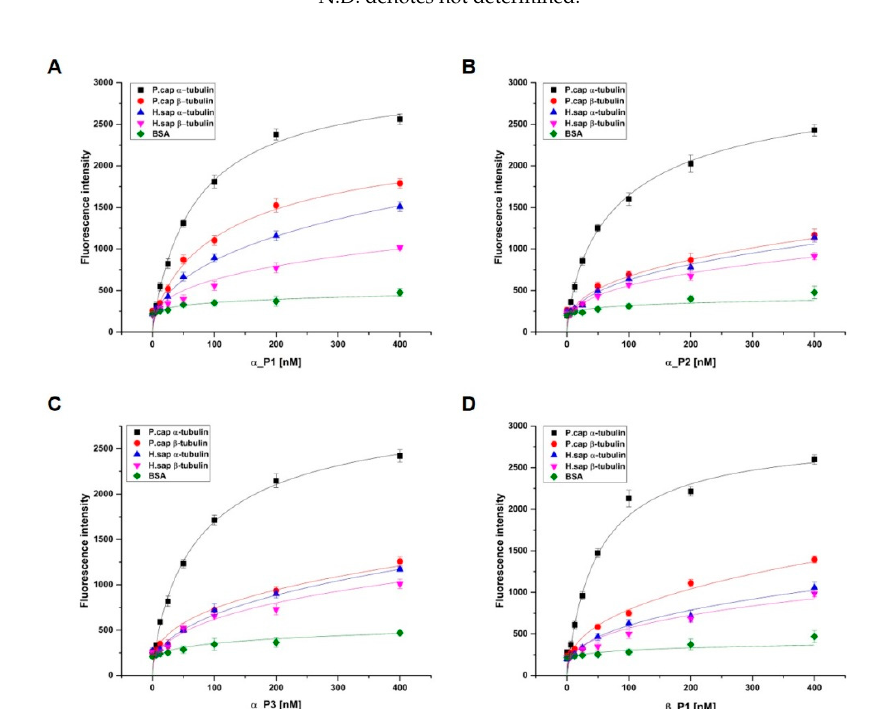
Figure 4. Determination of peptide specificities ( A ) α _P1, ( B ) α _P2, ( C ) α _P3, and ( D ) β _P1. Binding reactions were performed with a constant concentration of 2% BSA, 5 µ g each of α , β -tubulin of P. capsici and H. sapiens in a 96-well white plate as a target and various concentrations of each peptide (0–400 nM). The specificities of the bound peptides were measured using a fluorometric method and were plotted against the concentration of the peptides used in the binding reaction. The data are representative of one of three independent experiments, and the specificities were obtained from nonlinear fitting of the saturation–binding curves.